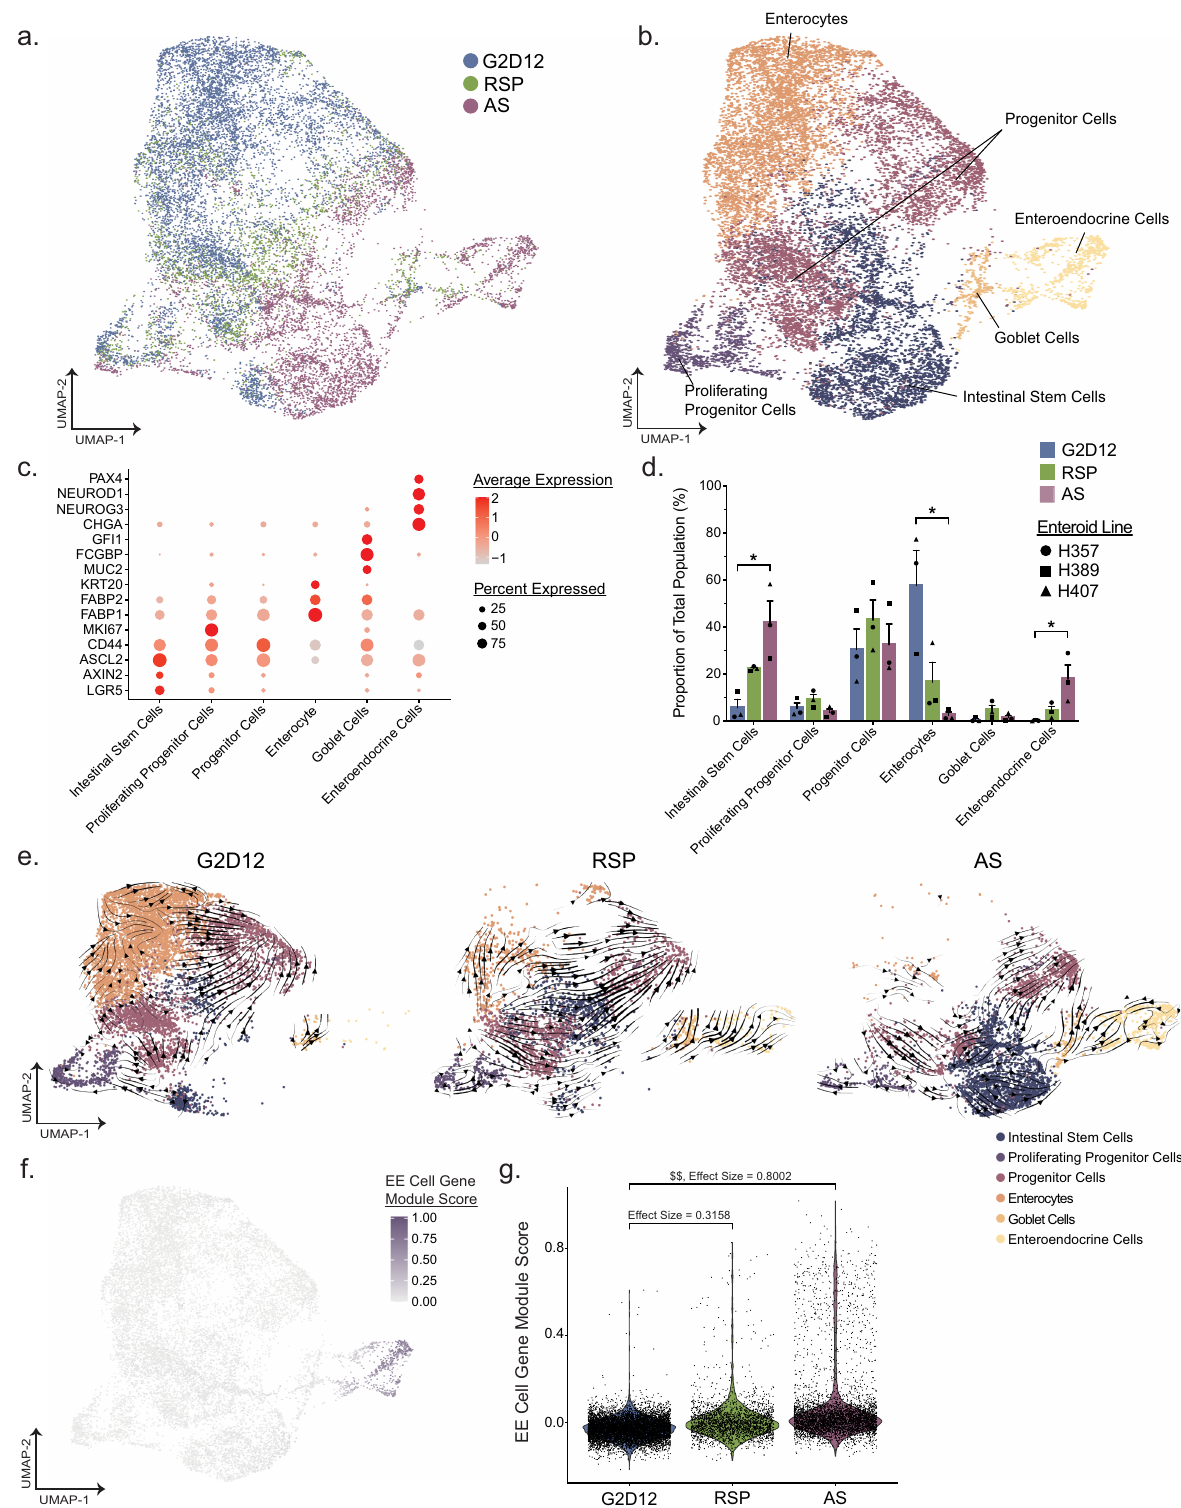
expressed between AS and RSP, while MLN , associated with M cells, was identi fi ed predominantly in RSP-treated cells, although these markers, along with GAST , associated with G cells, GIP , and CCK , were expressed in only a small number of cells (Supplementary Fig.